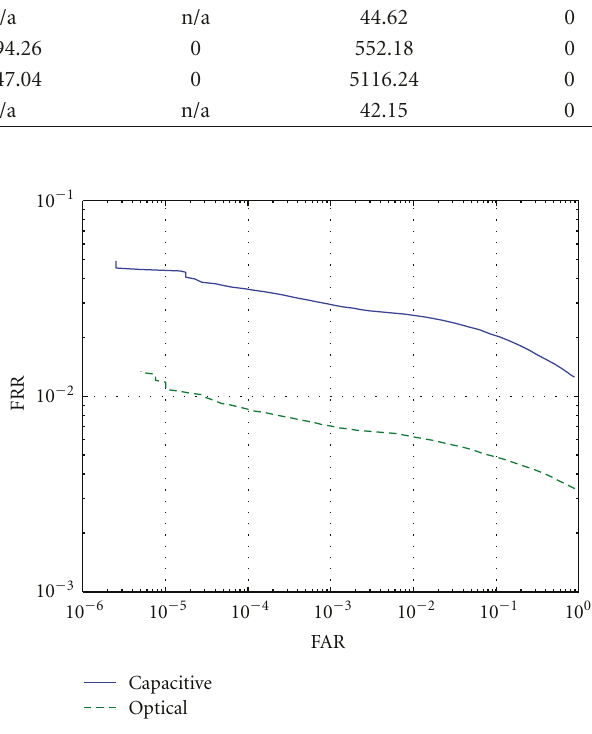
Figure 1: DET curves for the capacitive (solid line) and optical (dashed line) sensors based on the full database (including failures to